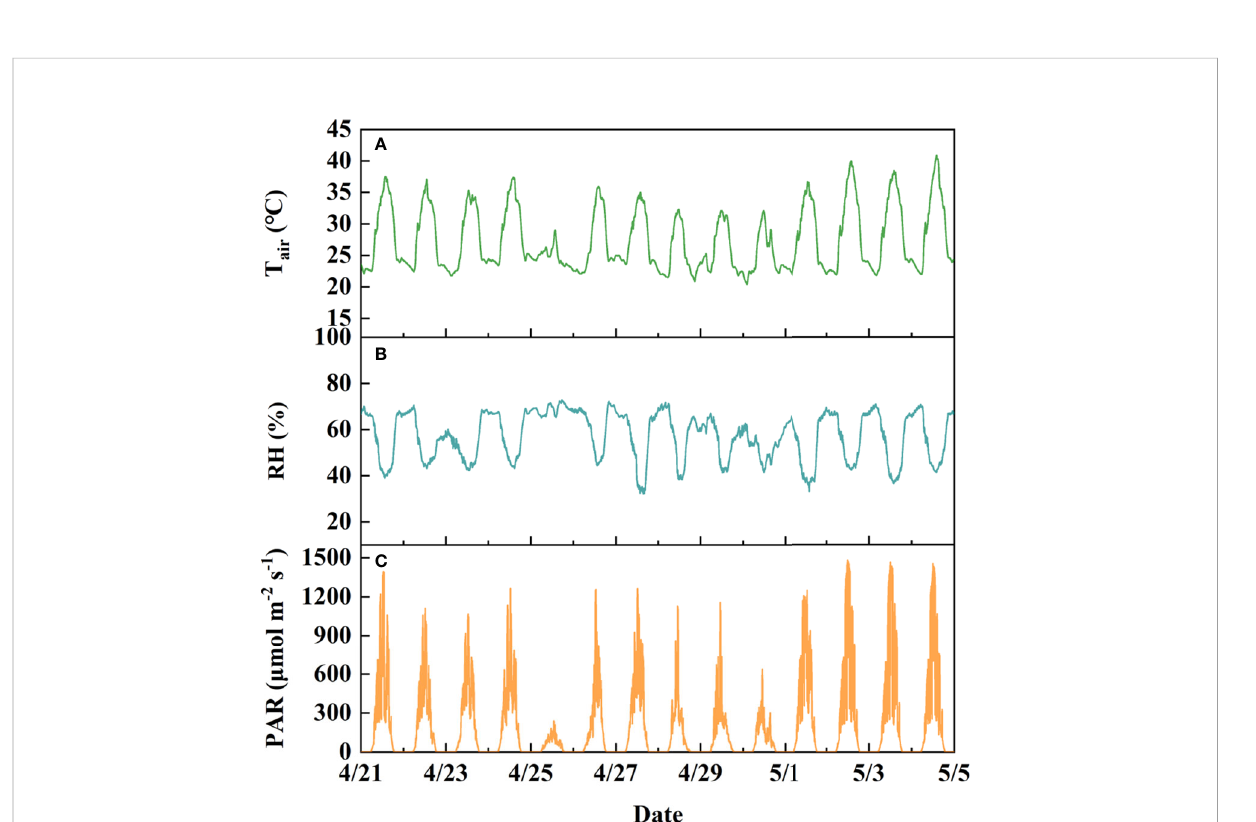
FIGURE 2 Parameters of the soil – plant – atmosphere continuum monitored by “ Plantarray ” . (A) , air temperature (T air , °C). (B) , Relative humidity (RH, %). (C) , Photosynthetic active radiation (PAR, m mol m -2 s -1 ). The data shown in the graph were obtained from the spring-season experiment in